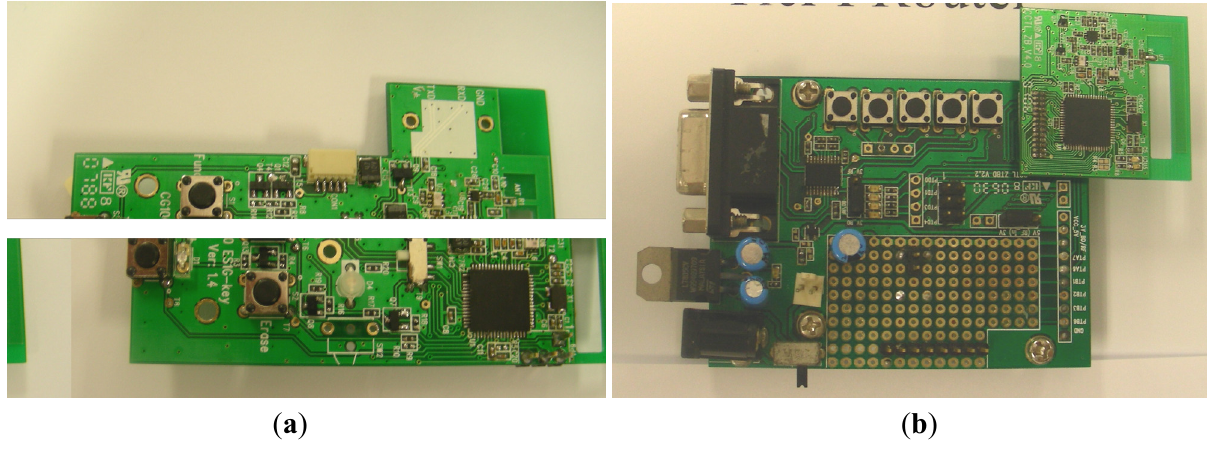
Figure 8. ZIPMS: ( a ) handheld ( b ) frontend